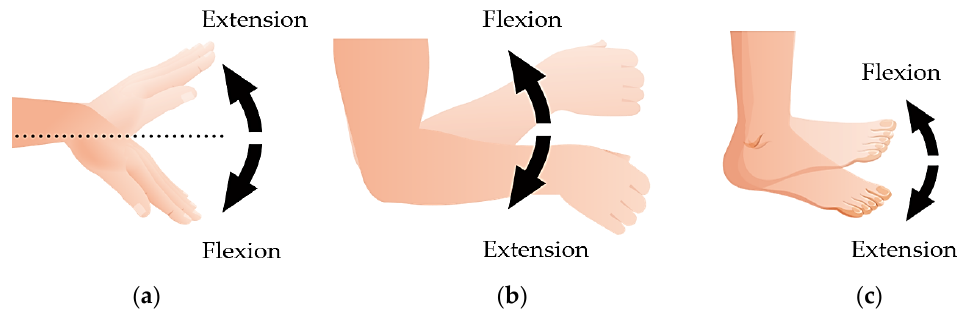
Figure 2. The example of left and right sides of upper and lower limb movement paradigms to investigate user proficiency with motor imagery for paradigms recommendation: ( a ) the left wrist flexion/extension; ( b ) right elbow flexion/extension; ( c ) right ankle flexion/extension.